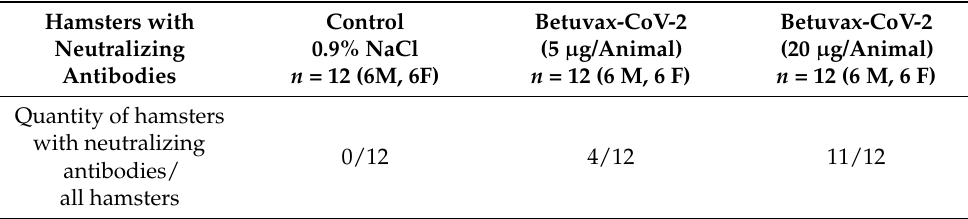
Table 2. Golden hamsters with neutralizing antibodies against